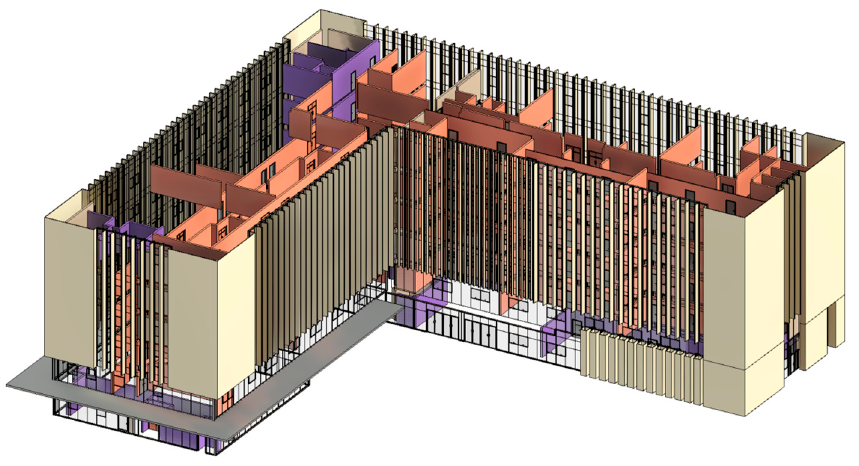
Figure 18. Structural system of assembly model.